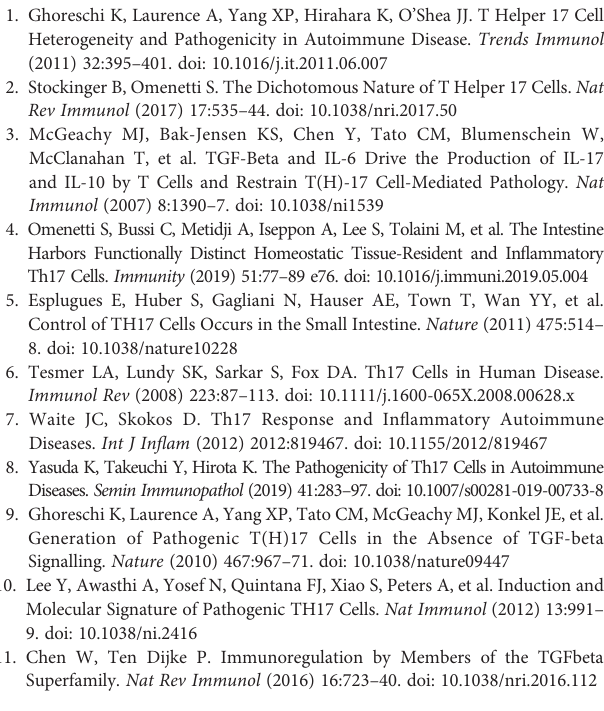
Supplementary Figure 2 | Uncropped gel images with size marker indications.This fi le contains Supplementary Figures 2 : Uncropped western blot